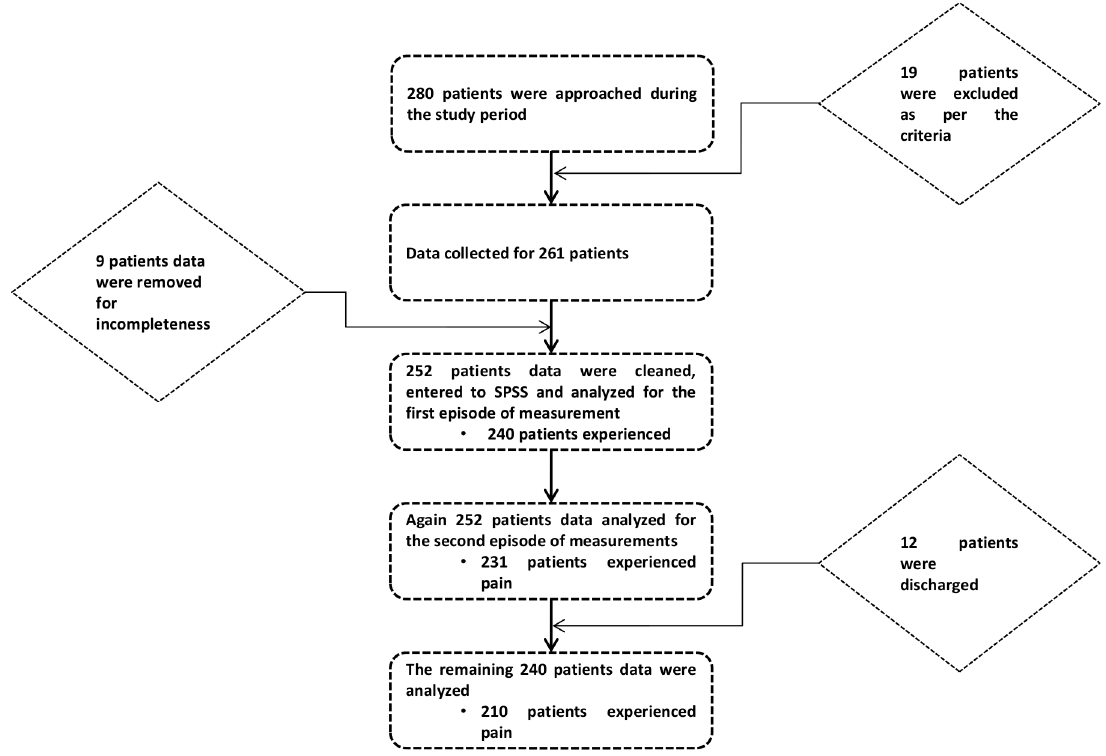
Figure 1. Schematic representation of patient recruitment and data analysis.